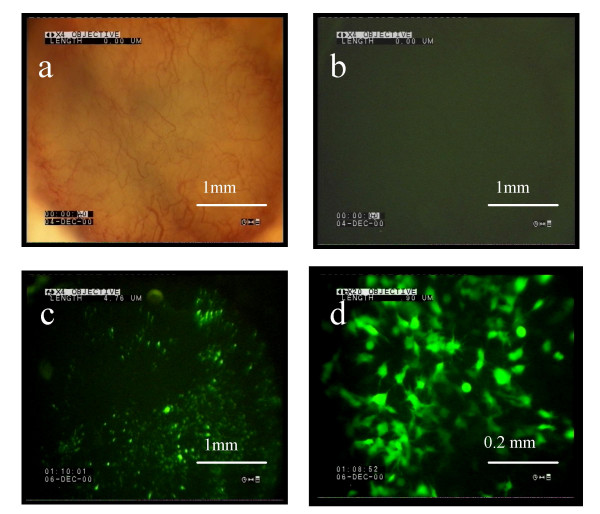
Expression of GFP following electroporation-assisted gene delivery using EP1 GFP expression was monitored in the rat P22 tumor growing in rat dorsal flap window chamber following electroporation-assisted gene delivery using EP1 (8 electric pulses, 600 V/cm, 5 ms, 1 Hz). a. image taken under visible light condition on day 0 (x4 objective), b. image taken under fluorescence epi-illumination on day 0 before administration of DNA and electroporation (x4 objective), c. image taken under fluorescence epi-illumination on day 2 (x4 objective); d. image taken under fluorescence epi-illumination on day 2 (x20 objective).